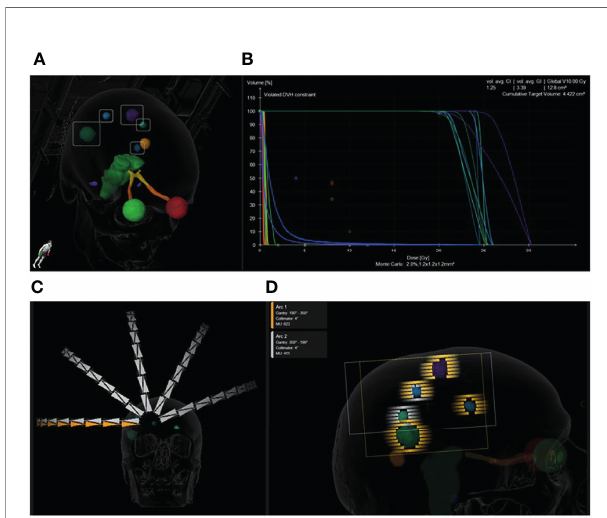
FIGURE 4 | Graphical representation of a single isocentre dynamic conformal arc plan prescribed to 1 x 20 Gy for a patient with 7 brain metastases from non-small cell lung cancer. Five metastases were treated with this plan. The 6 th and 7 th were located inferiorly and were irradiated with 1 x 20 Gy in a second plan to maintain the distance of the PTVs from the isocentre below 5 cm. 3D view of the location and size of the metastases (A) . Dose volume histogram showing >99% coverage of the PTVs with 100% dose and minimal dose to the organs at risk. The cumulative PTV volume was 4.4cm 3 and the cumulative volume of brain receiving 10 Gy is 12.8cm 3 . The mean conformity index for each PTV was 1.25 and the mean gradient index for each PTV was 3.39 (B) . 10 dynamic conformal arcs (5 duplicated non-coplanar arcs) were used to achieve the desired dose distribution (C) . 2.5mm MLC leaves were used to conform to the spherical metastases. Arc 1 (orange) treated 4 brain metastases along its path and Arc 2 (white) treated three on the return trajectory (D)